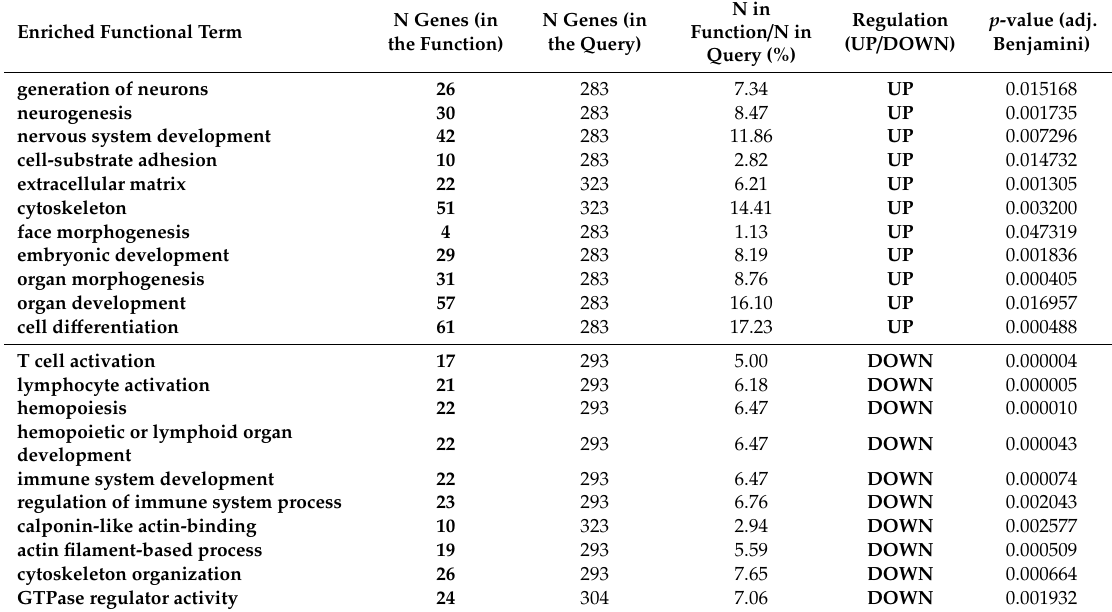
Table 1. Functional enrichment analysis done with the top 10 master regulators (TFs) found upregulated (UP) and their corresponding gene regulons and with the top 10 master regulators (TFs) downregulated (DOWN) and their corresponding gene regulons. The genes asigned to each function are included in Supplementary Table